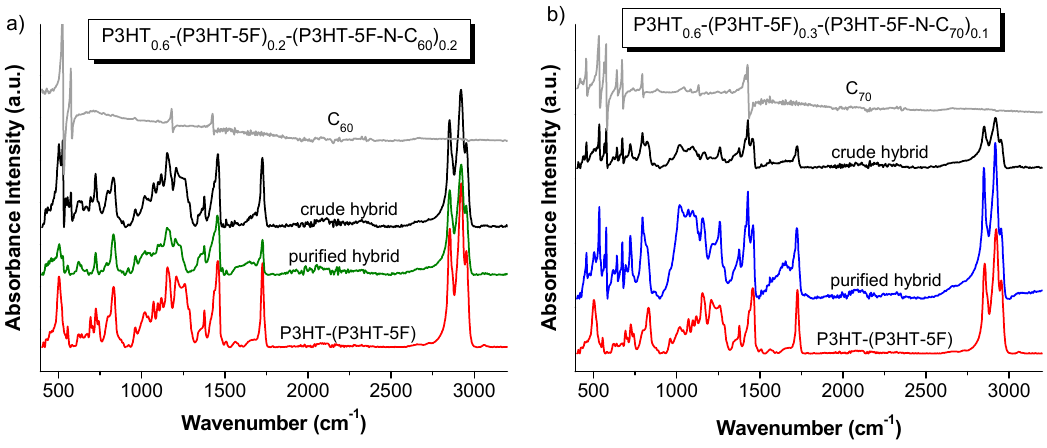
Figure 6. ATR spectra of: ( a ) C 60 ; and ( b ) C 70 based side [(P3HT 0.6 -P3HT-5F) 0.4 ] hybrids, in comparison with the initial P3HT-(P3HT-5F) and the plain fullerenes, respectively. Thermogravimetric analysis (TGA) of the side -functionalized [P3HT 0.6 -(P3HT-5F) 0.4 ] and